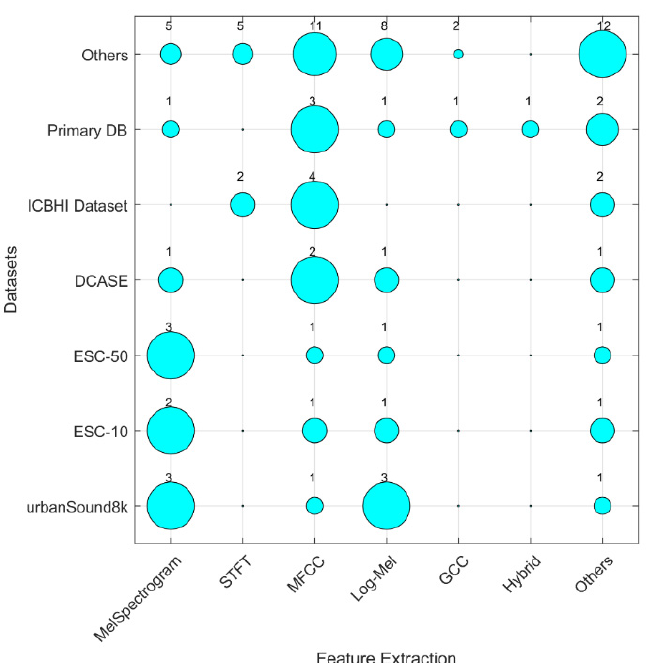
Figure 12. Bubble plot of publications by feature extraction method and the dataset used. The size of the bubble is proportional to the number of published publications (given above the bubble) and bubble coordinates correspond to the feature extraction method and the dataset used.